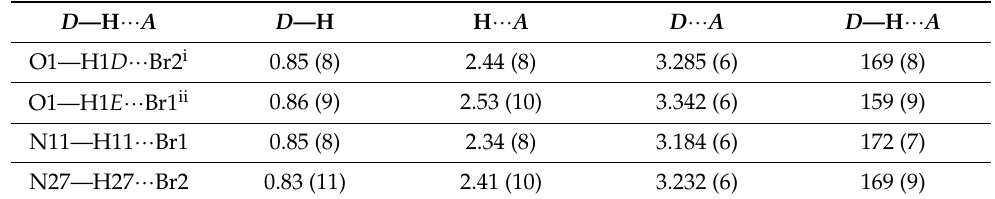
Figure 14. The crystal packing of 5 . Figure 15. The intermolecular hydrogen bonds in compound 5 . Figure 15. The intermolecular hydrogen bonds in compound 5 . Table 6. Strong hydrogen-bond geometry (Å, º) for 5 Table 6. Strong hydrogen-bond geometry (Å, º) for 5 .